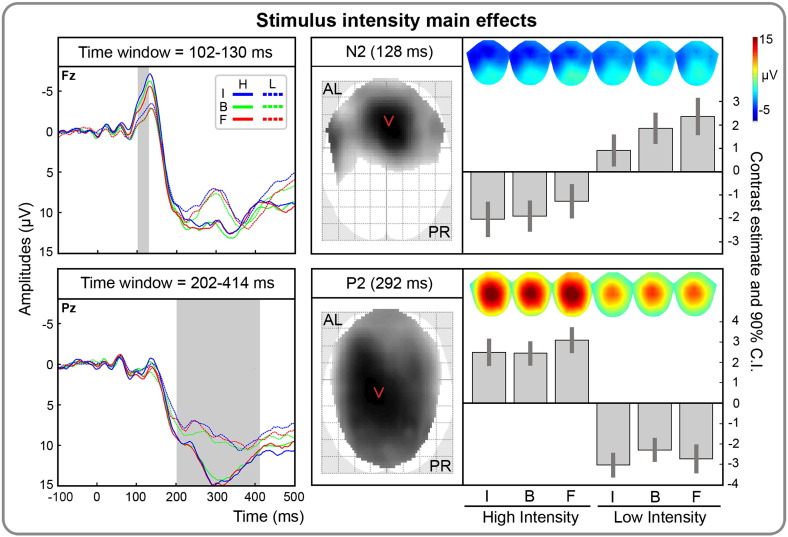
Temporal, spatial and effect size information associated with the stimulus intensity main effects at the scalp-level. First column. Grand-mean ERPs, time locked to the stimulation, separately for painful (full line) and non-painful stimuli (dotted line) and for instruction (blue = inhibition, I; green = baseline, B; red = facilitation, F). Time scale is from − 100 to 500 ms. Negativity is displayed upward. The gray areas represent the temporal extent of significant stimulus intensity main effects at the cluster level (pFWE < .05 cluster-level; pUNC < .001 peak-level). The significant time-windows are overlaid in gray on a representative channel. In the top panel, the significant stimulus intensity main effect between 102 and 130 ms, corresponding to increased N2 amplitudes for high vs. low stimulus intensity, is displayed over Fz. In the bottom panel, the significant stimulus intensity effect between 202 and 414 ms, corresponding to increased P2 amplitudes for high vs. low stimulus intensity, is depicted over Pz. Second column. Statistical parametric maps overlaid over the glass brain showing the spatial extent of the significant effects at 128 and 292 ms (i.e., when maximally significant). Topographical maps, as well as contrast estimates and 90% confidence intervals are depicted for the maximally significant effects at 128 ms and 292 ms for high and low intensity stimuli and for each instruction (inhibition, I; baseline, B; facilitation, F). AL = anterior left; PR = posterior right.